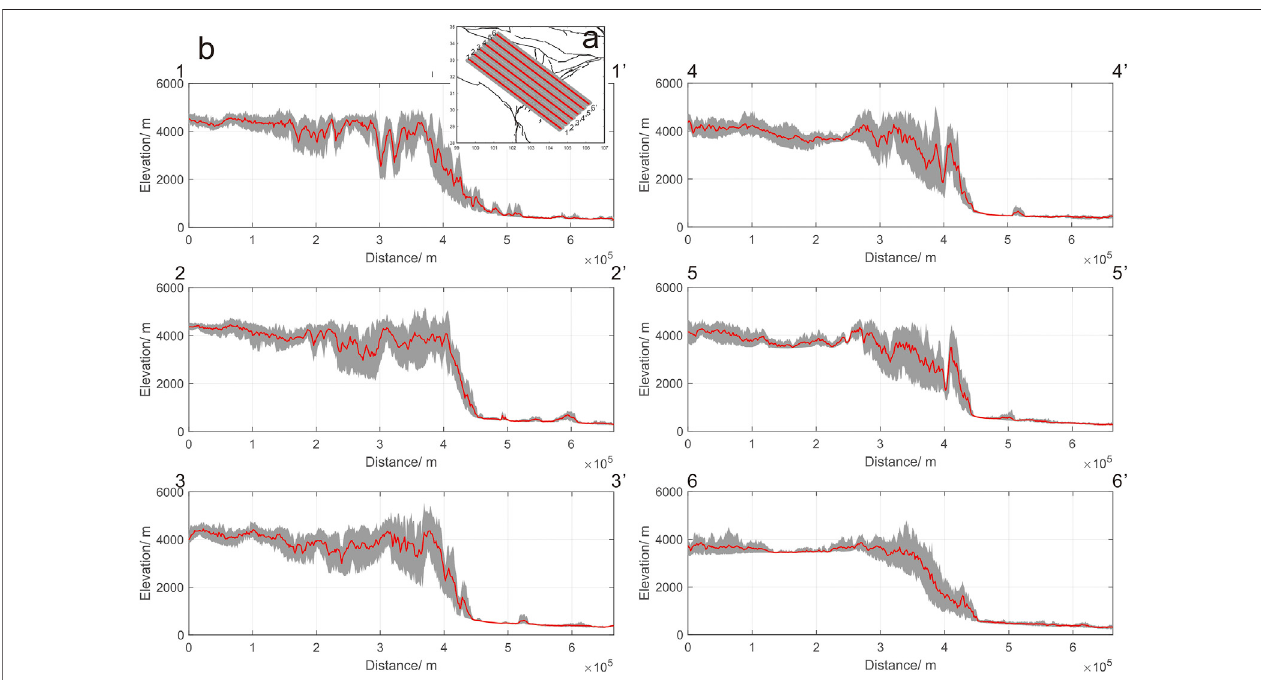
FIGURE3|(A) 6pro fi lescrosstheLongmenShanfault,everysectionwas500 kminlengthand25 kminwidth. (B) Pro fi les1-1 ′ ,2-2 ′ ,and3-3 ′ crossthesouthern Longmen Shan fault, and Pro fi les 4-4 ′ , 5-5 ′ , and 6-6 ′ cross the northern Longmen Shan fault. The red line indicates the average elevation. The gray range indicates the highest and lowest elevation